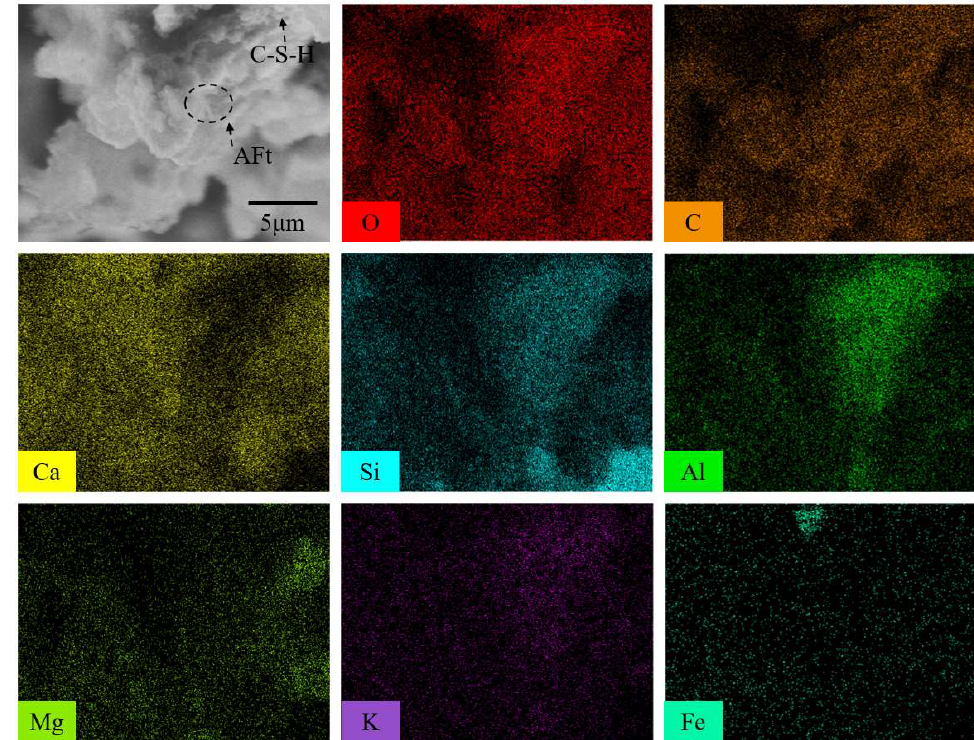
Figure 13. The main element mapping distributions of FRCTWRF sample.